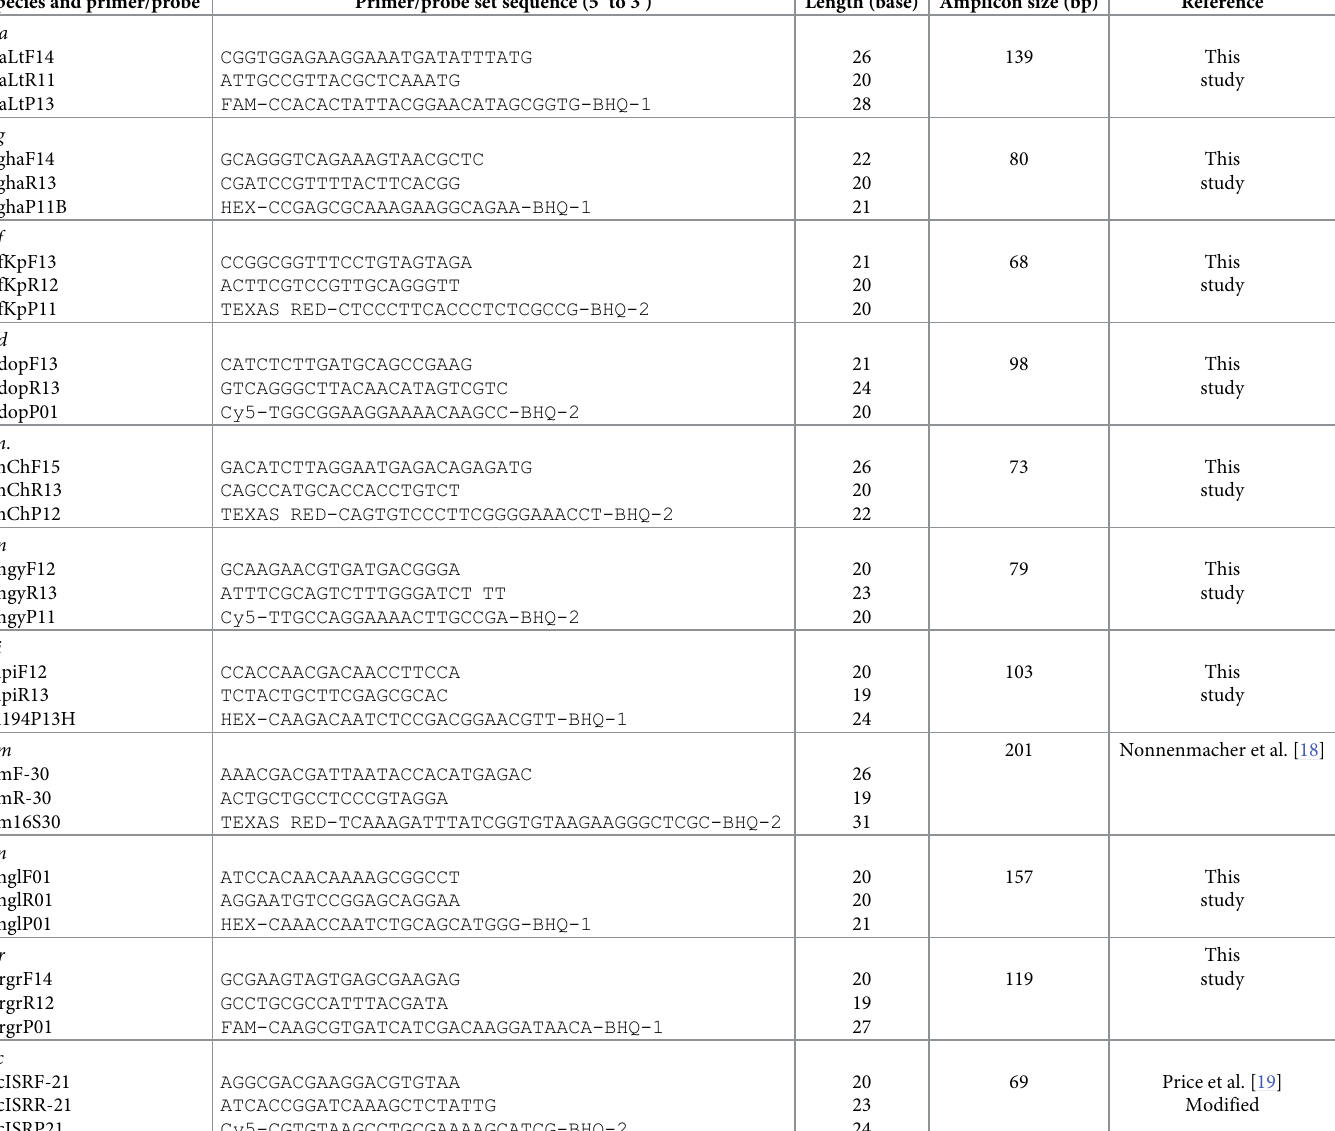
Table 1. Targeted oral bacteria and primer/probe set sequence used for quantification real-time PCR. Species and